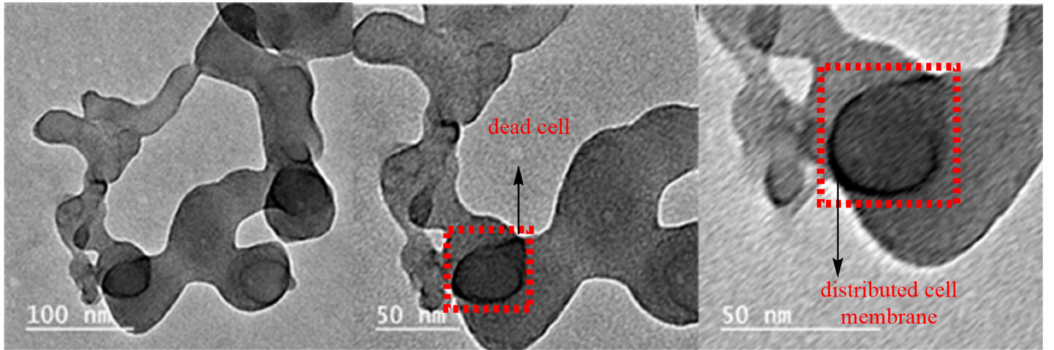
Figure 5. TEM micrographs of methicillin-resistant Staphylococcus aureus ( MRSA ) treated with 10a showing incomplete cell wall destruction, cell death.